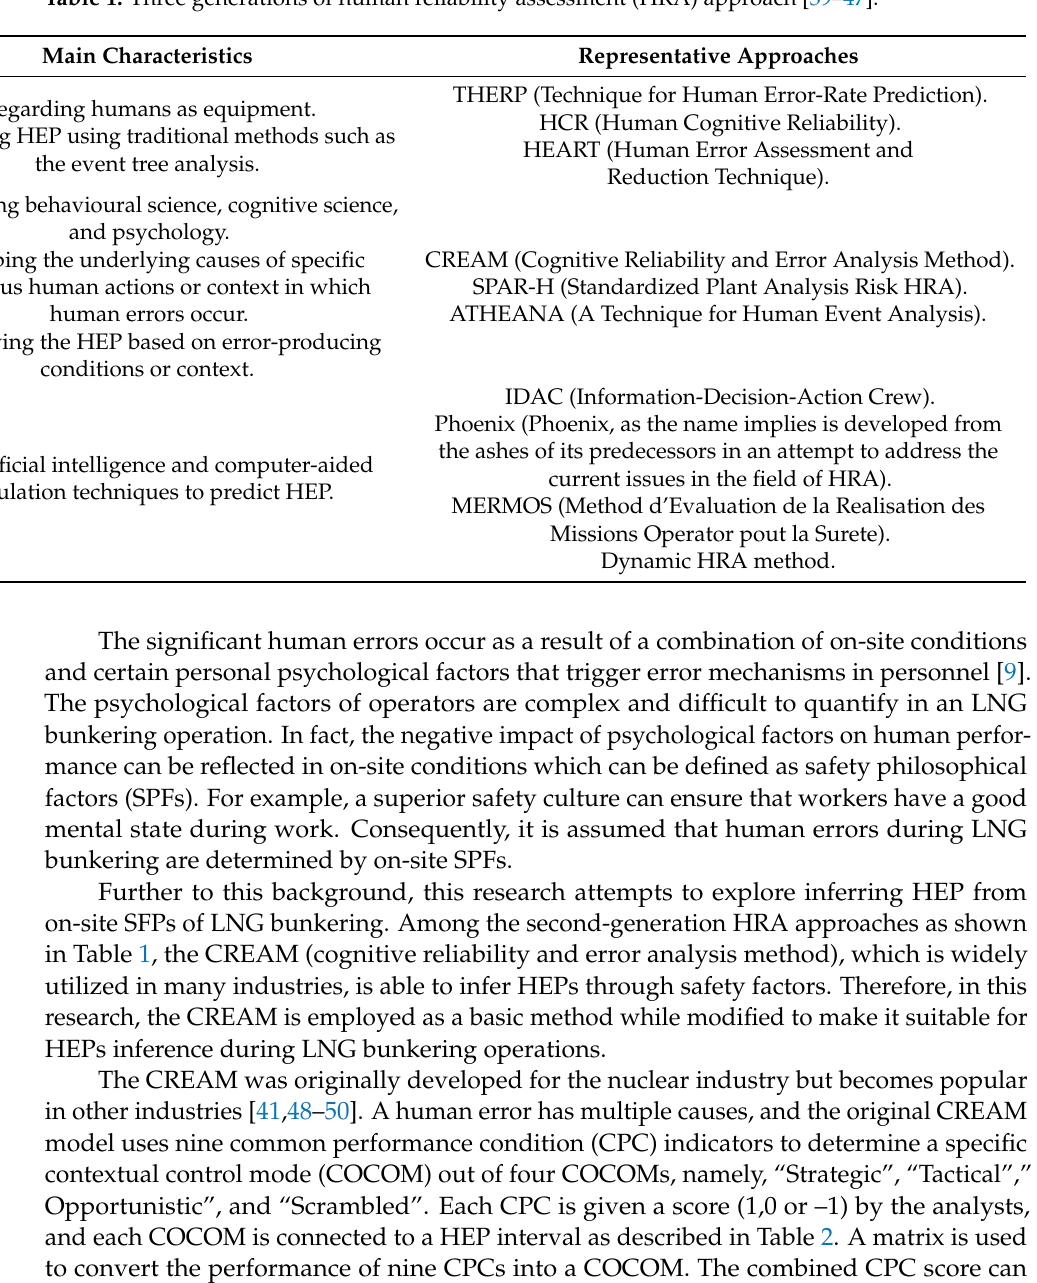
Table 1. Three generations of human reliability assessment (HRA) approach [39–47].